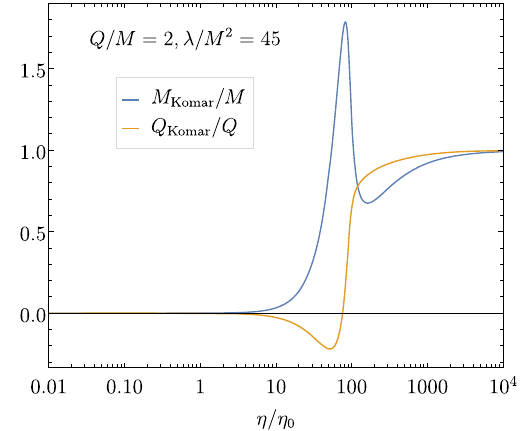
Fig. 8 Same as Fig. 5 for Q / M = 2 and λ/ M 2 = 45